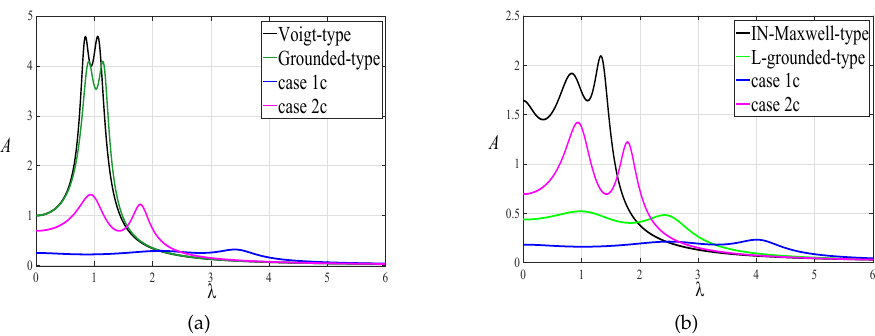
Figure 11. Comparison of amplitude–frequency response curves with other DVAs: ( a ) Comparison of classical DVA with our results. ( b ) Comparison of IN-Maxwell-type, L-grounded-type DVA with our results.